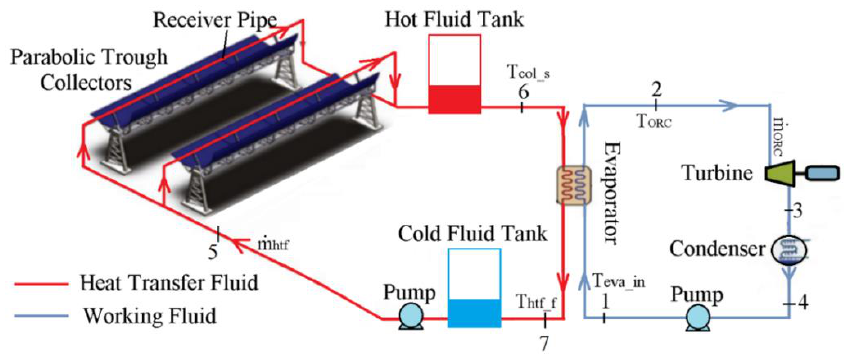
Figure 1. Configuration of the integrated Parabolic Trough Collectors and ORC system, adapted from [16].